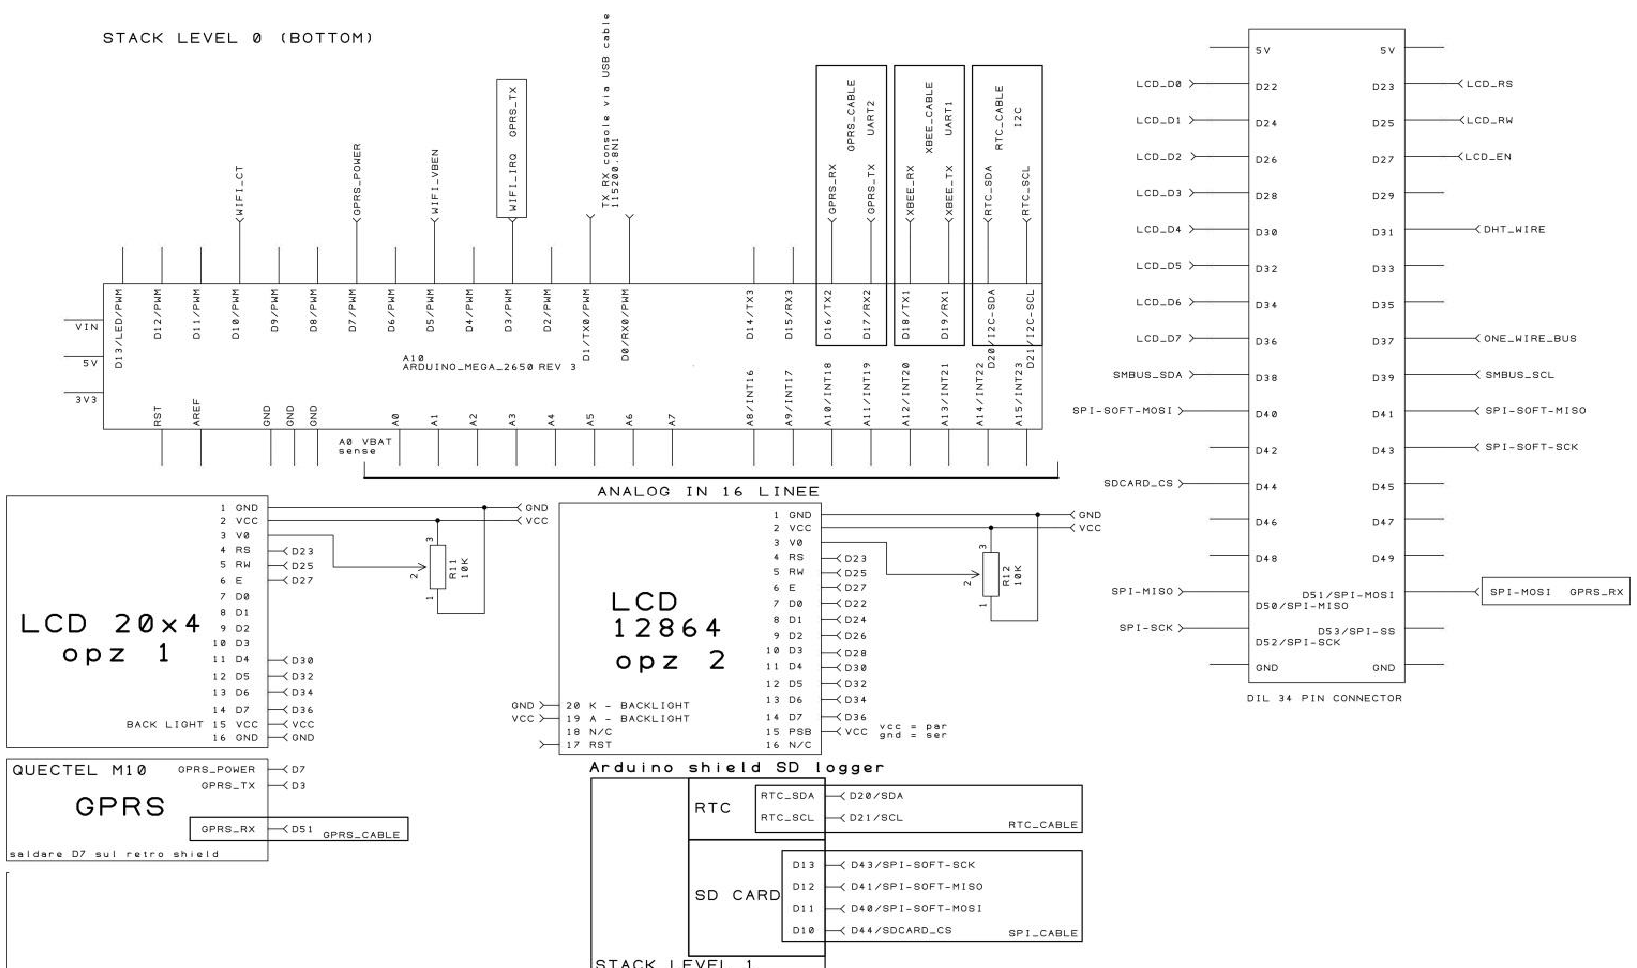
Scheme 1. Schematic electric diagram of the